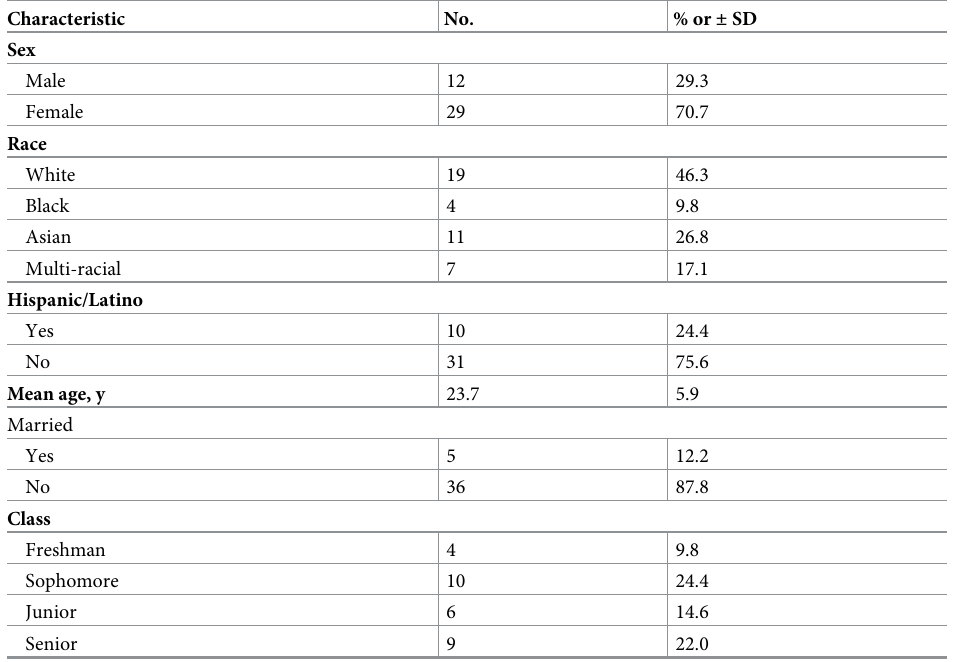
Table 1. Sociodemographic characteristics of student participants (n =